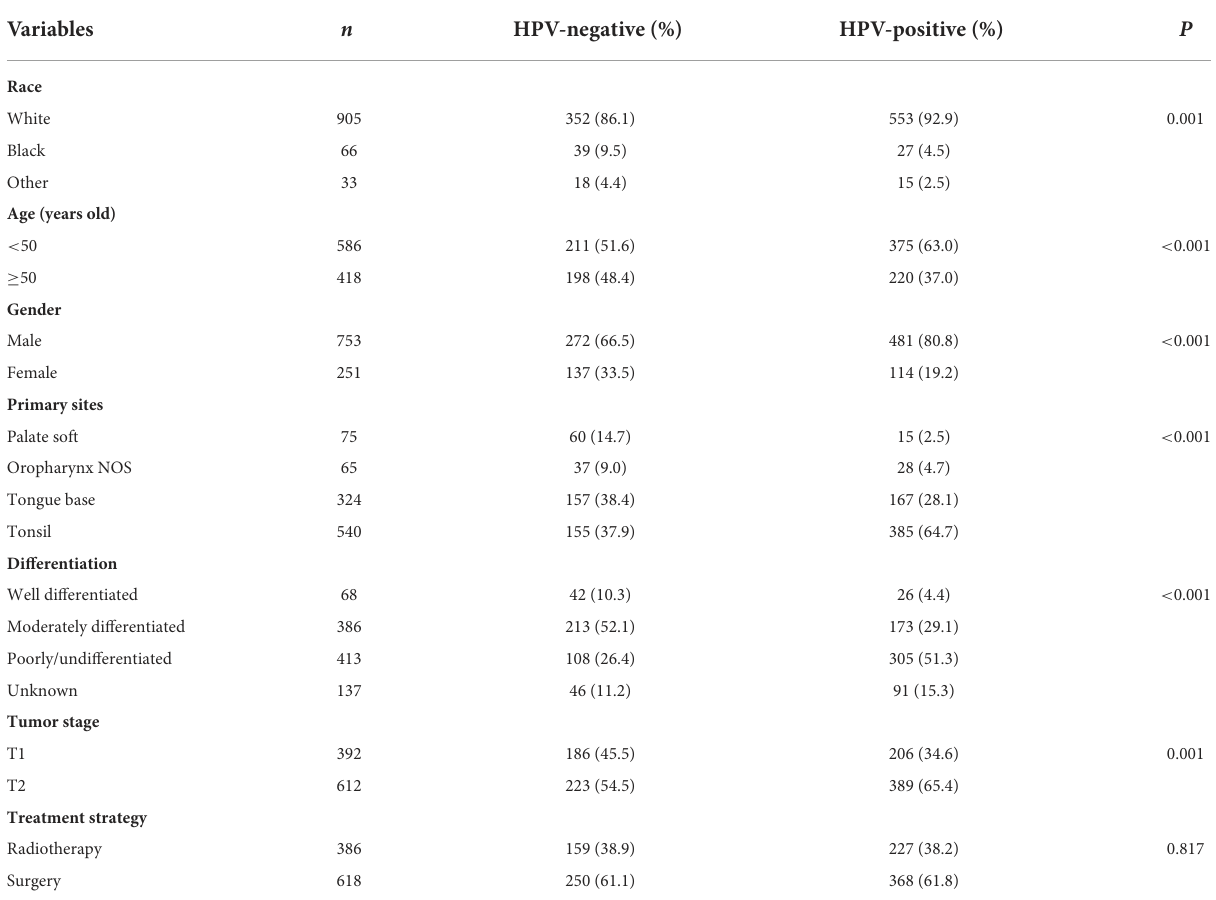
TABLE 2 Patient and treatment characteristics by HPV